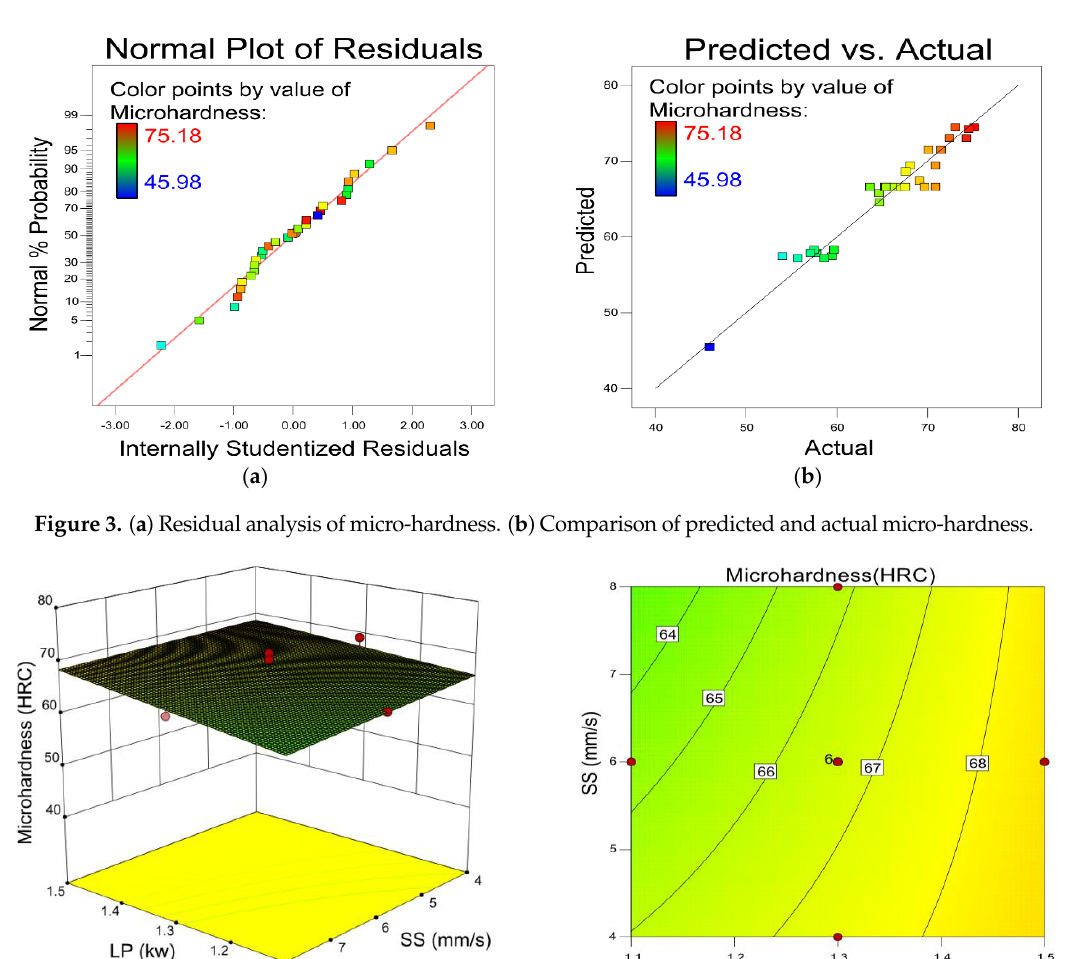
Materials 2019 , 12 , x FOR PEER REVIEW